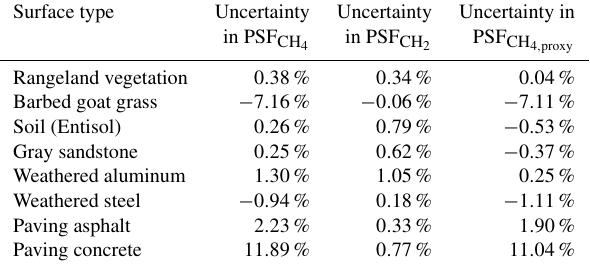
Table 3. Uncertainty estimate of PSF CH due to the assumption of a constant albedo over PSF CH 4 , proxy different surfaces. As long as there is a constant surface type, a large value does not principally hinder source detection. However, especially paving or man-made structures vary spatially with non-man-made structures, so false positive hits due to surface reflectance are